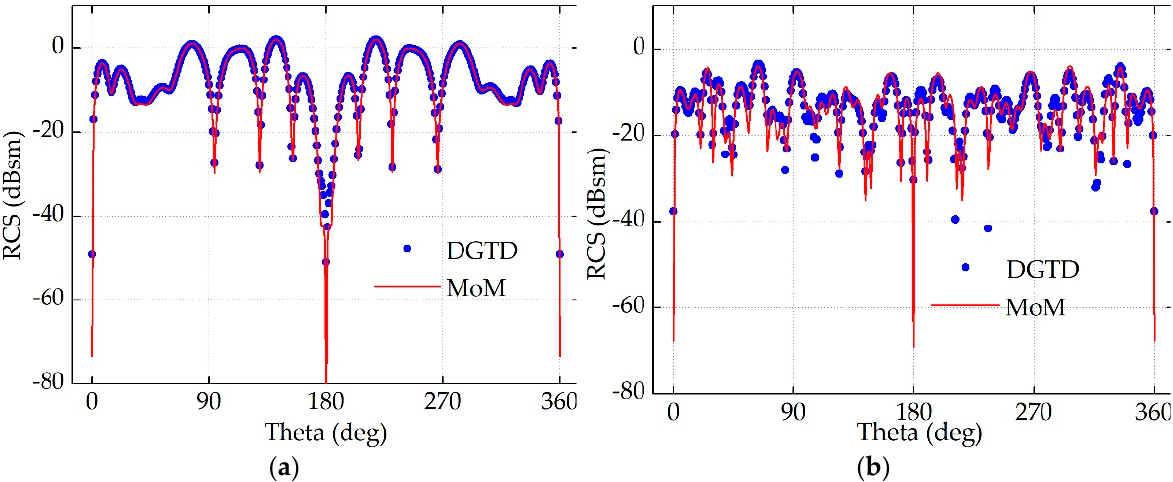
Figure 13. The RCS of multiple objects computed at ( a ) 1 GHz and ( b ) 1.5 GHz from the solutions of the DGTD method